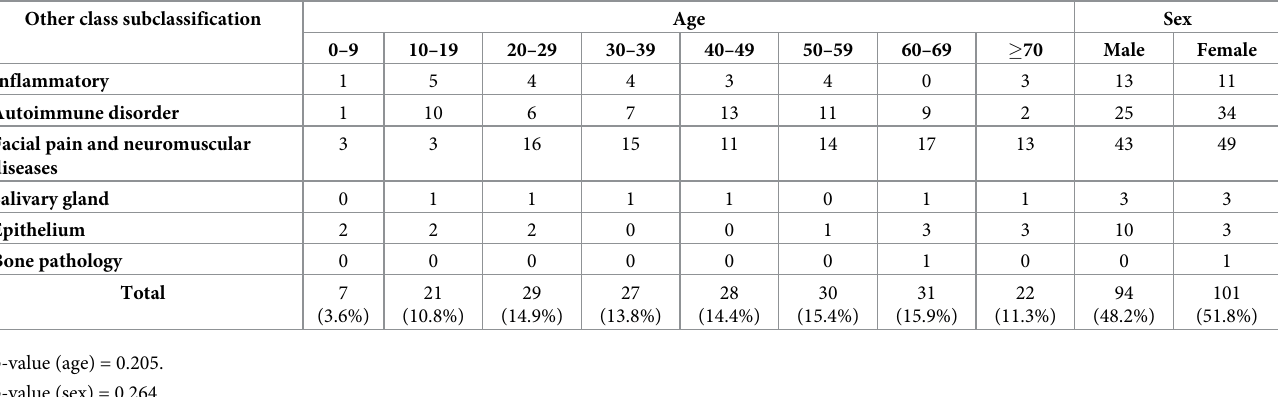
Table 10. Sex and age effect on other class.